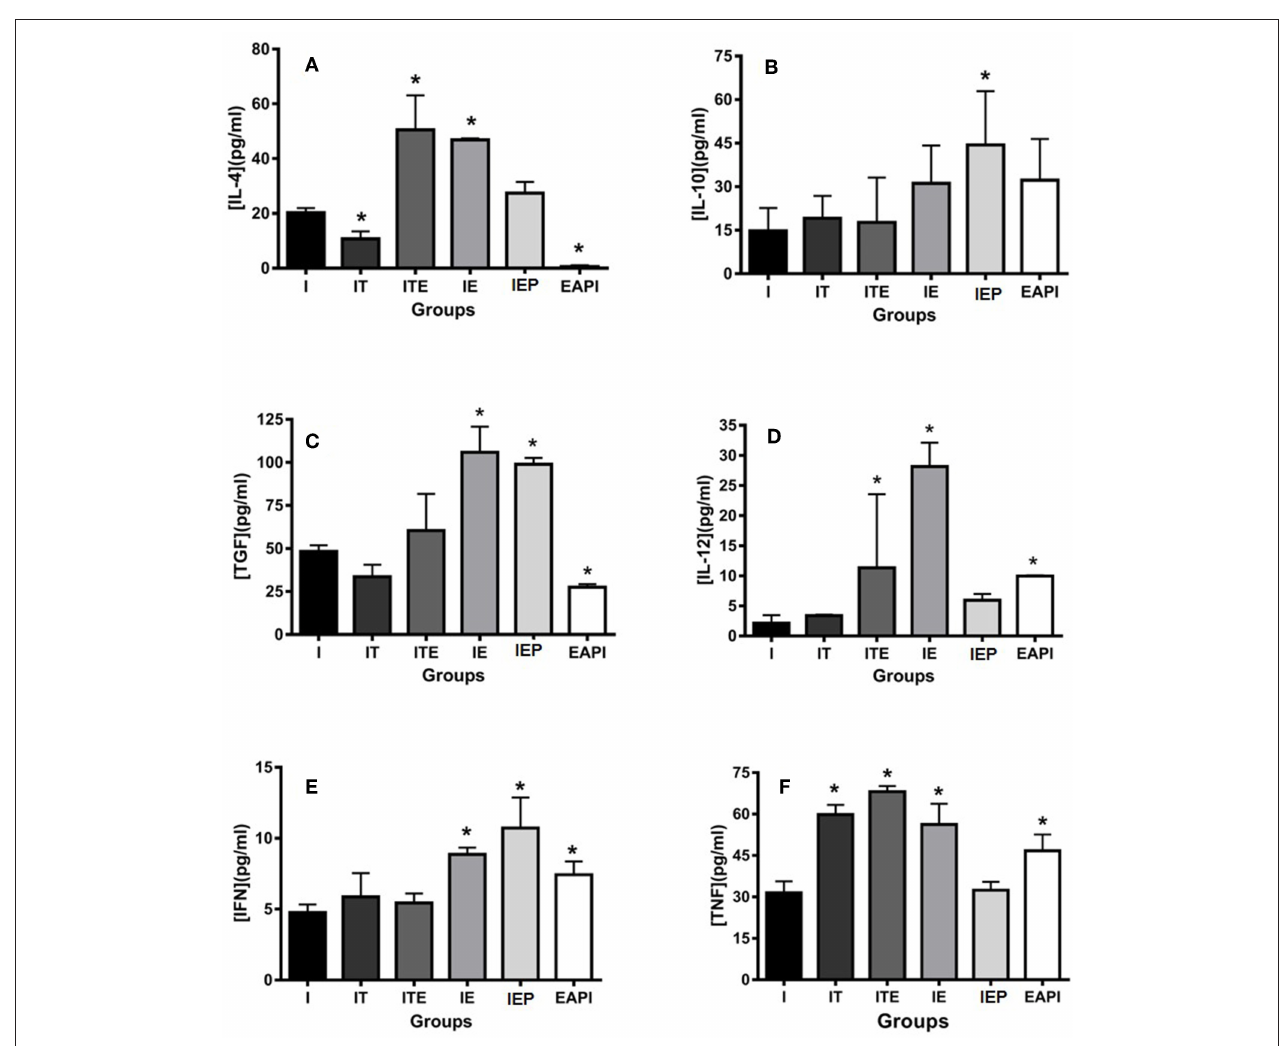
FIGURE 6 | Effect of physical exercise on cytokine production by cells in the paws of infected BALB/c mice. The cytokines IL-4 (A) , IL-10 (B) , TGF- β (C) , IL-12 (D) , IFN- γ (E) and TNF (F) were determined by ELISA (see Material and Methods). Values represent the mean of two experiments with samples of the eight animals per group grouped as a pool. The bars represent the standard error. C—Non-infected sedentary. E—Trained not infected. I—Infected. IT—Animals infected and treated with a therapeutic dose (8mg) of Glucantime ® , after the onset of the lesion. ITE—Animals infected, trained and treated with therapeutic dose (8mg) of Glucantime ® after the onset of injury. IE—Animals infected and trained from the first week of infection. IEP—Animals infected and trained after the appearance of the lesion (6 th week). EAPI—Animals trained for 6 weeks, infected and trained for another 12 weeks. * P < 0.05 with respect to